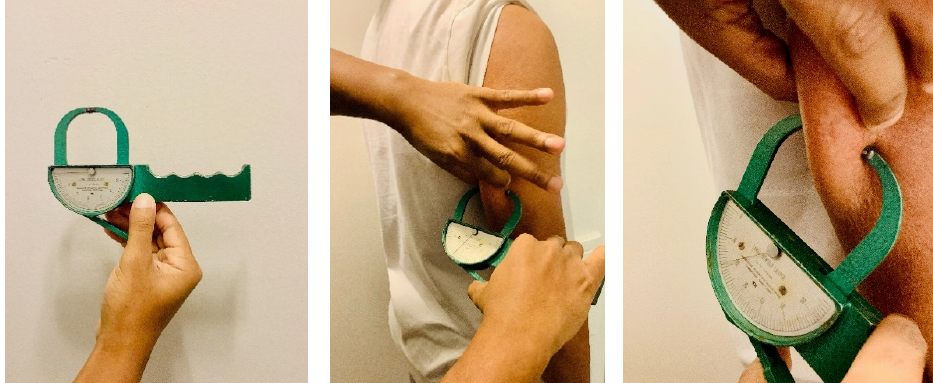
Figure 1. Skinfold measurement at triceps site; photo courtesy of Clifton J. Holmes, PhD.